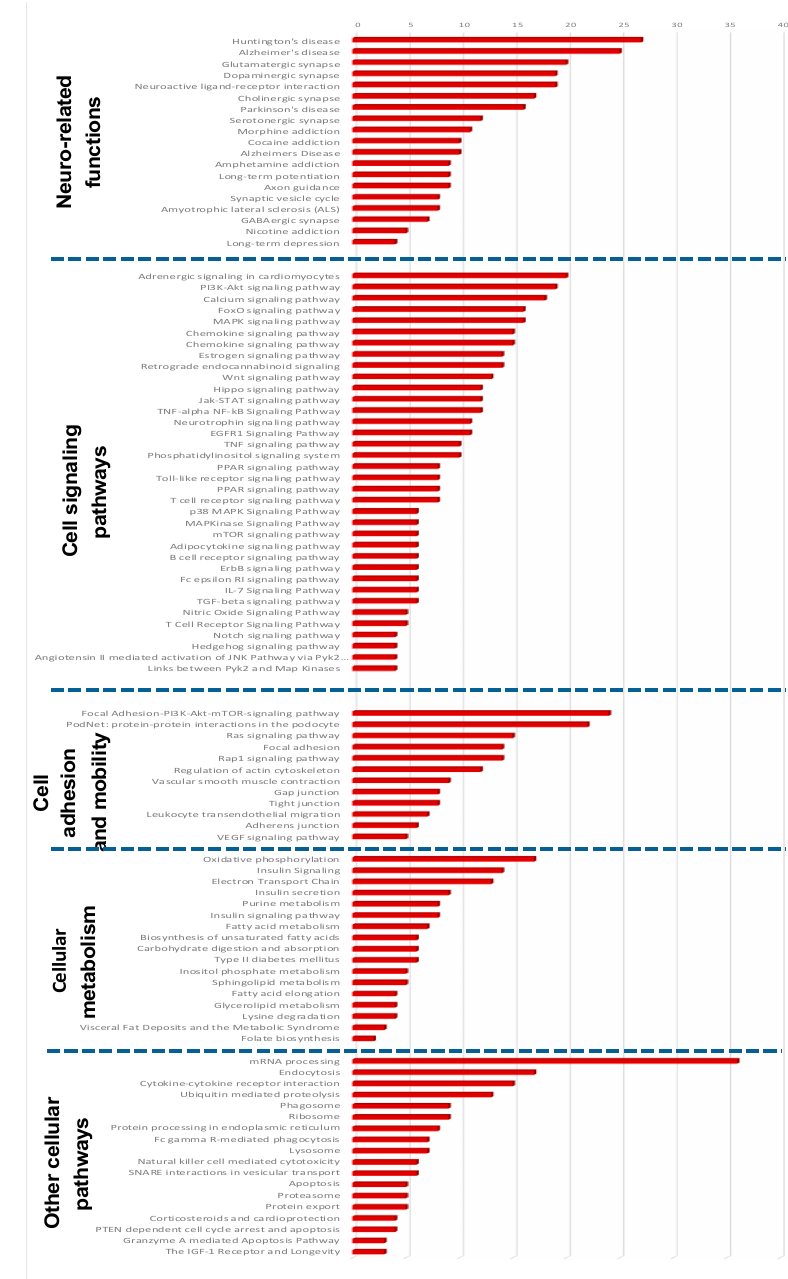
Figure 8. Effect of the high glycemic diet (HGD) with soluble epoxide hydrolase inhibitor (sEHI) on cellular pathways of differentially expressed protein-coding genes, miRNA targets, and LncRNA targets in the hippocampal microvasculature. ( A ) Network of differentially expressed protein-coding genes (grey circles), transcription factors (red hexagons), miRNAs (green diamonds) and their targets (blue circles), LncRNAs (purple rectangles) and their targets (blue circles) in the hippocampal microvessels for the high glycemic diet (HGD) with soluble epoxide hydrolase inhibitor (sEHI) when compared to HGD without sEHI. ( B ) Histogram of subset of relevant pathways of differentially expressed protein-coding genes, miRNA targets, and LncRNA targets in the hippocampal microvasculature for the HGD+sEHI vs HGD. The data are shown for three biological replicates for each dietary group. Statistically significant pathways ( p < 0.05) were identified using Genetrial2 online database and are grouped by cellular function such as neuro-related, cell signaling, cell adhesion and mobility, cellular metabolism, and